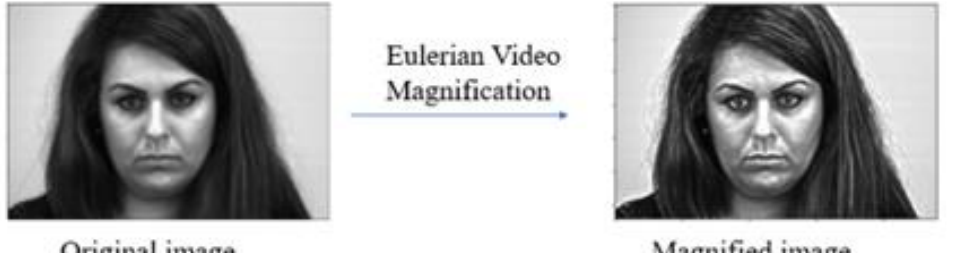
Figure 8. Amplification of facial motion by EVM.